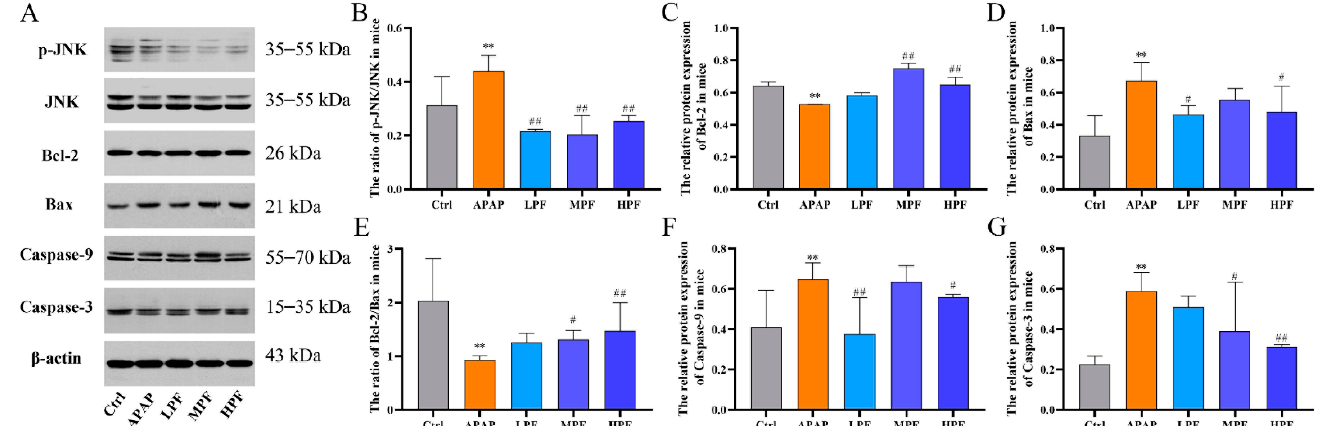
Figure 8. Effects of PF on the CYP2E1/JNK-signal-related protein expressions with APAP stimulation. ( A ) Western blotting images of p-JNK, JNK, Bcl-2, Bax, caspase-9, and caspase-3. The relative protein expression of Bcl-2 ( C ), Bax ( D ), caspase-9 ( F ), and caspase-3 ( G ). The ratio of p-JNK/JNK in mice ( B ). The ratio of Bcl-2/Bax in mice ( E ). All data are presented as mean ± SD. ** p < 0.01, compared with control group; # p < 0.05, ## p < 0.01, compared with APAP group.